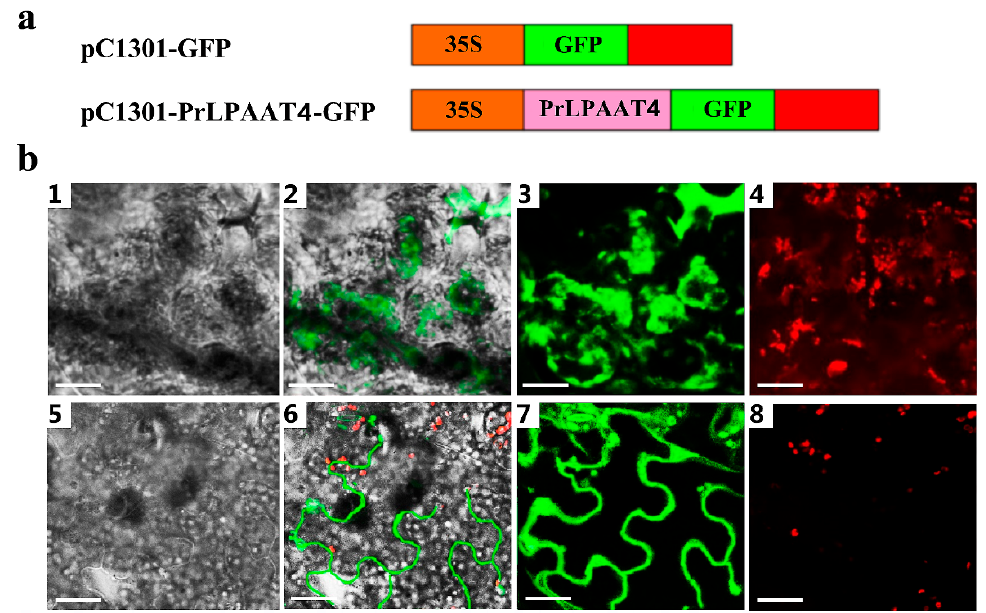
(Figure 5b). Nevertheless, the GFP fluorescence by the 35S:: PrLPAAT4 - GFP chimera was observed in the plasma membrane of tobacco lower epidermal cells, suggesting the localization of PrLPAAT4 to the plasma membrane (Figure 5b).